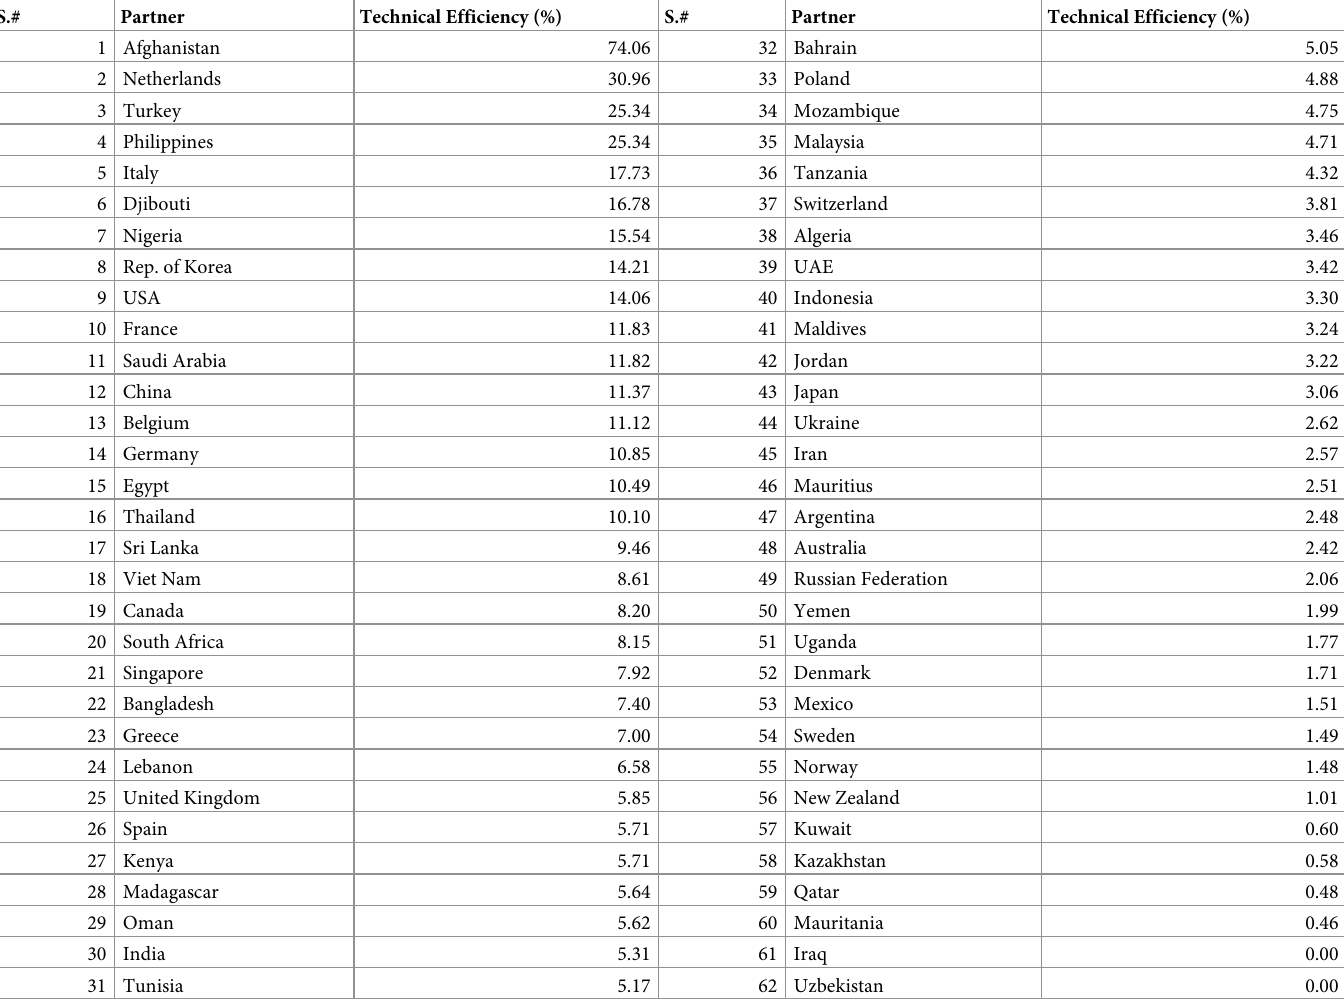
Table 5. Technical efficiency of chemical products’ exports with trading